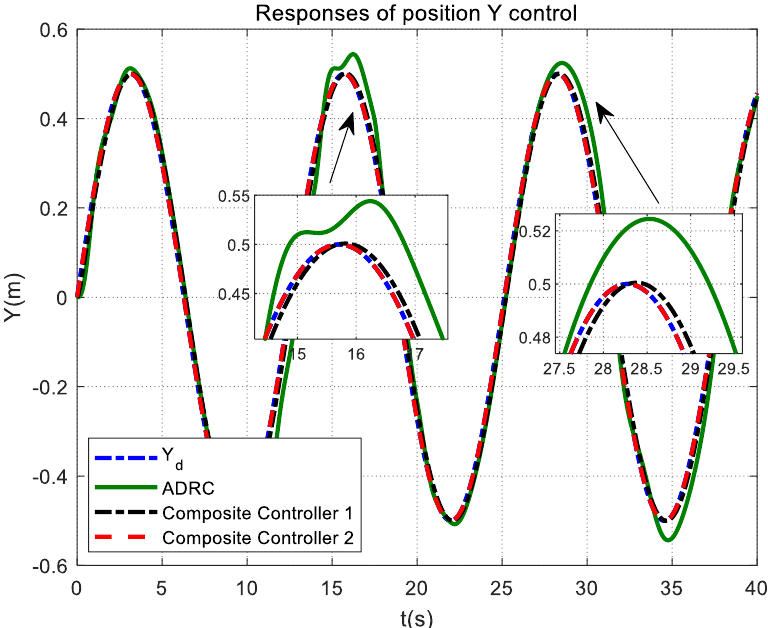
Figure 18. Responses of position Y control for QUAV under actuator time‑varying fault and disturbance condition.